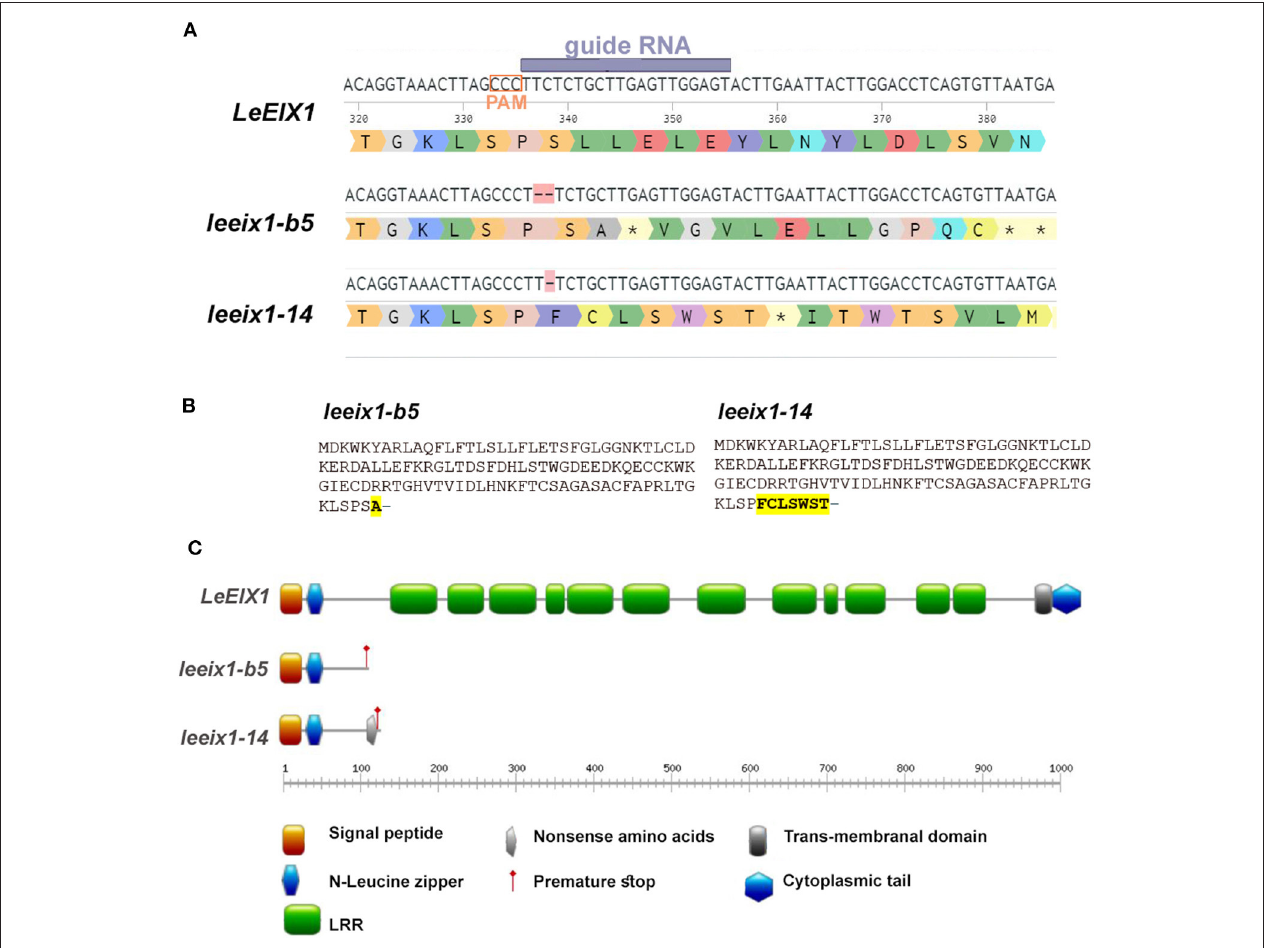
FIGURE 1 | Description of generated leeix1 lines. (A) Representation of gRNA/ PAM site and resultant mutations in the LeEIX1 sequence. (B) Predicted protein sequence of the mutants. (C) Protein domain analysis of LeEIX1 alongside the mutant truncated proteins. (A) Generated with Benchling (Biology Software) (2021). Retrieved from https://benchling.com. (C) Generated with Prosite MyDomain ( Hulo et al.,